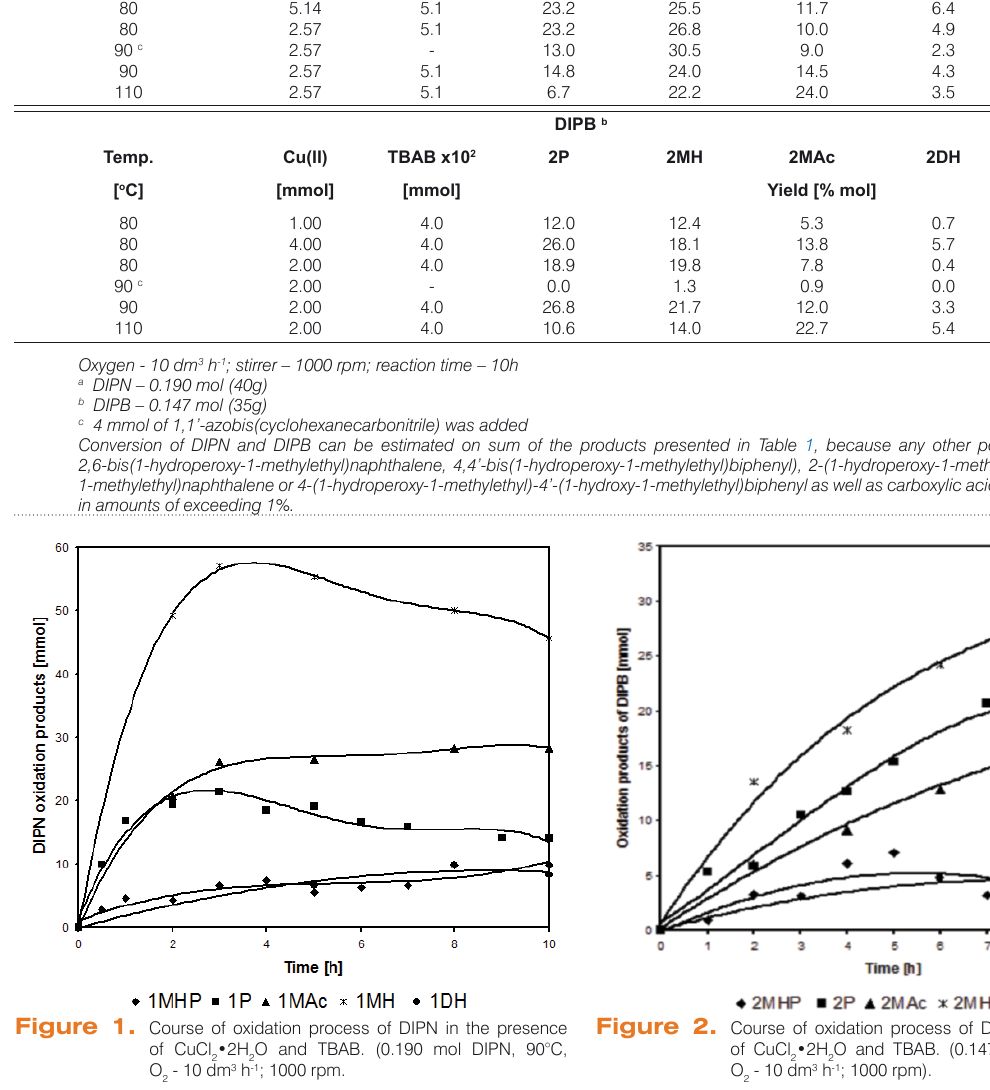
Figure 2. Course of oxidation process of DIPB in the presence